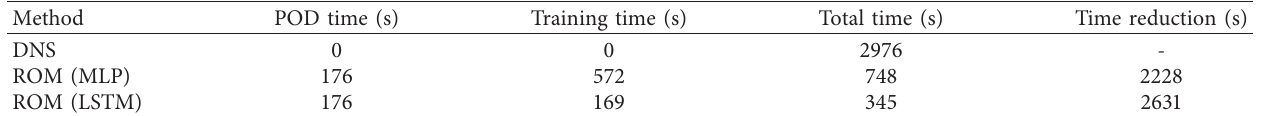
Table 4: Comparison of the calculation costs between DNS, MLP, and